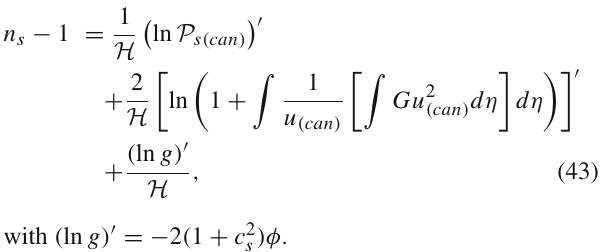
Fig. 2 Variation of n s over the α range of values. Note that the spectated values of n s relies in the α interval [− 0 . 157 , 0 . 12 ] , but − 0 . 157 ≤ α < 0 . 01 (red part of the above curve) is out of the range previouslyassumedin[14].Theverticalsolidblacklineindicates α =